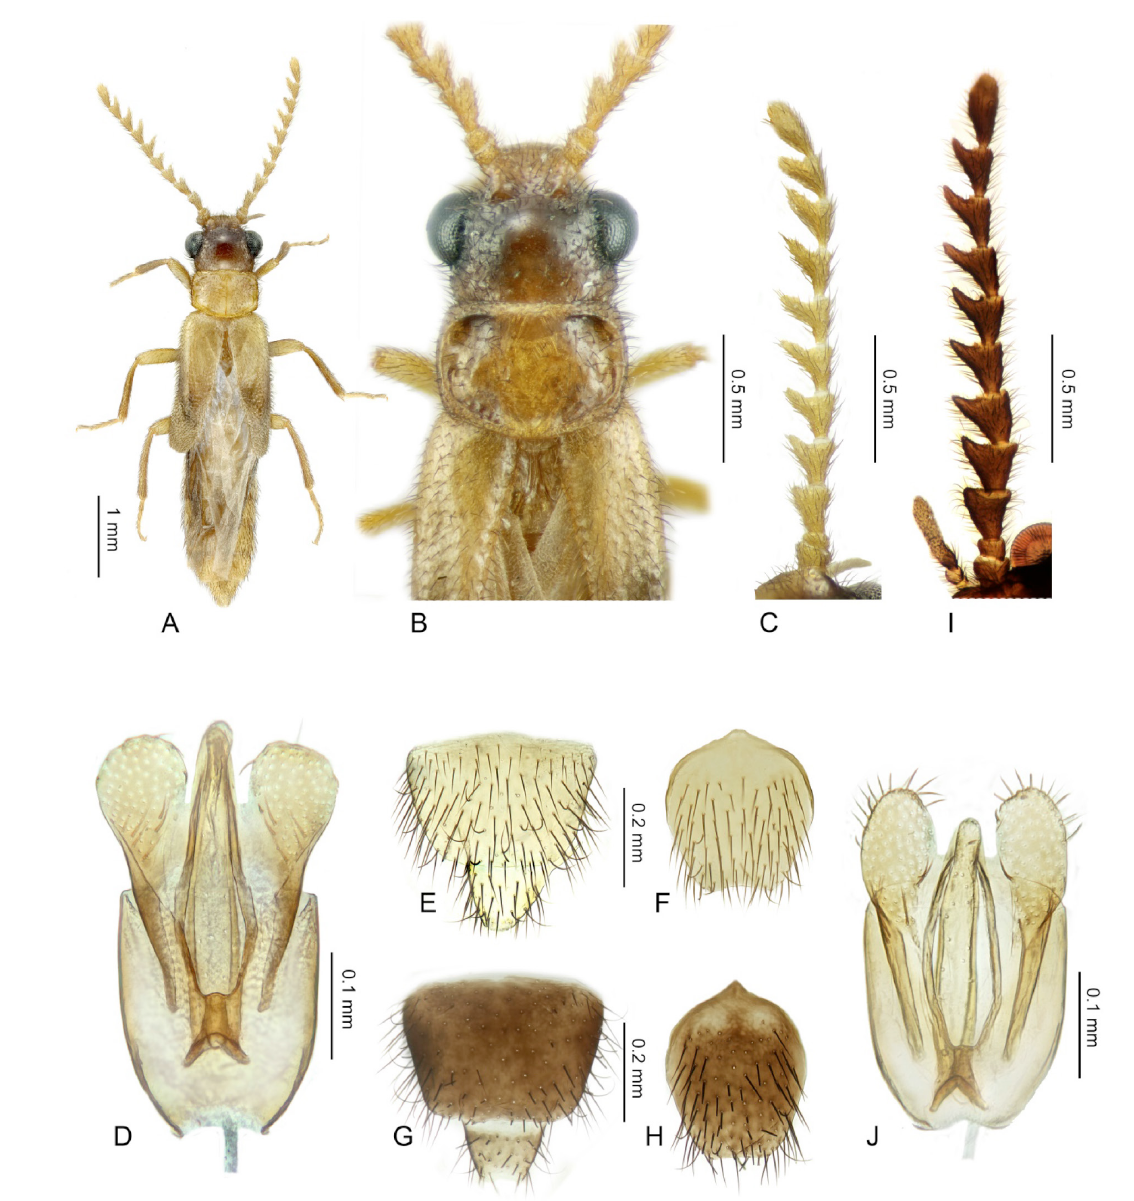
Fig. 2. A – F . Pseudotelegeusis meloi sp. nov., holotype from Madre de Dios, CICRA. A . Habitus. B . Detail of head and pronotum. C . Right antenna. D . Aedeagus, dorsal view. E . Tergites IX–X, dorsal view. F . Sternite IX, ventral view. G – I . Pseudotelegeusis howdeni Wittmer, 1976 specimen from French Guiana. G . Tergites IX–X, dorsal view. H . Sternite IX, ventral view. I . Right antenna. J . Aedeagus, dorsal